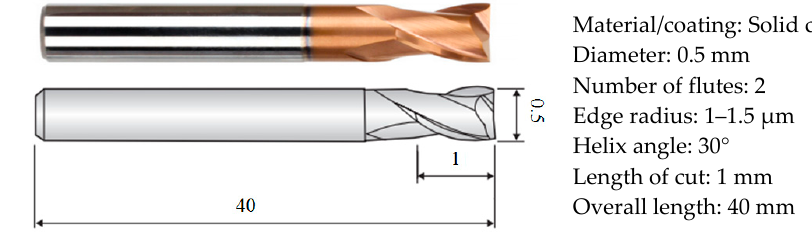
Figure 2. Geometric characteristics of the micro end mill.